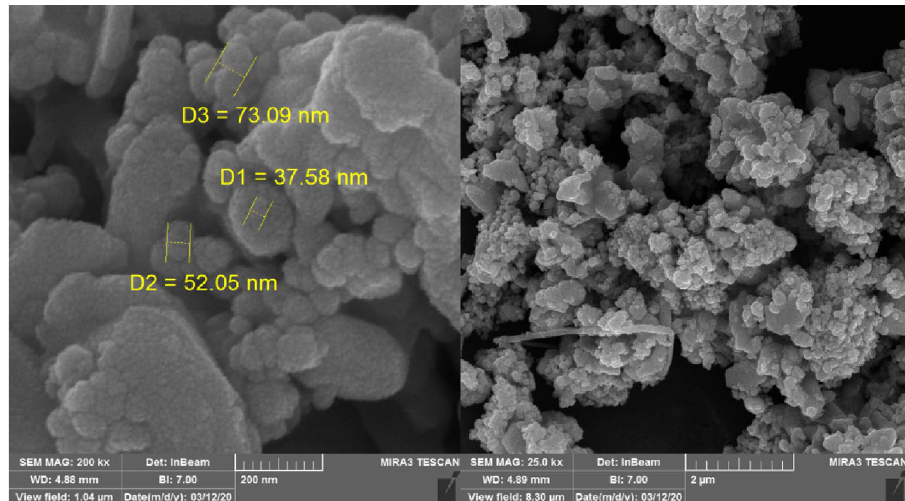
Figure 4. SEM images of Ag–CP.